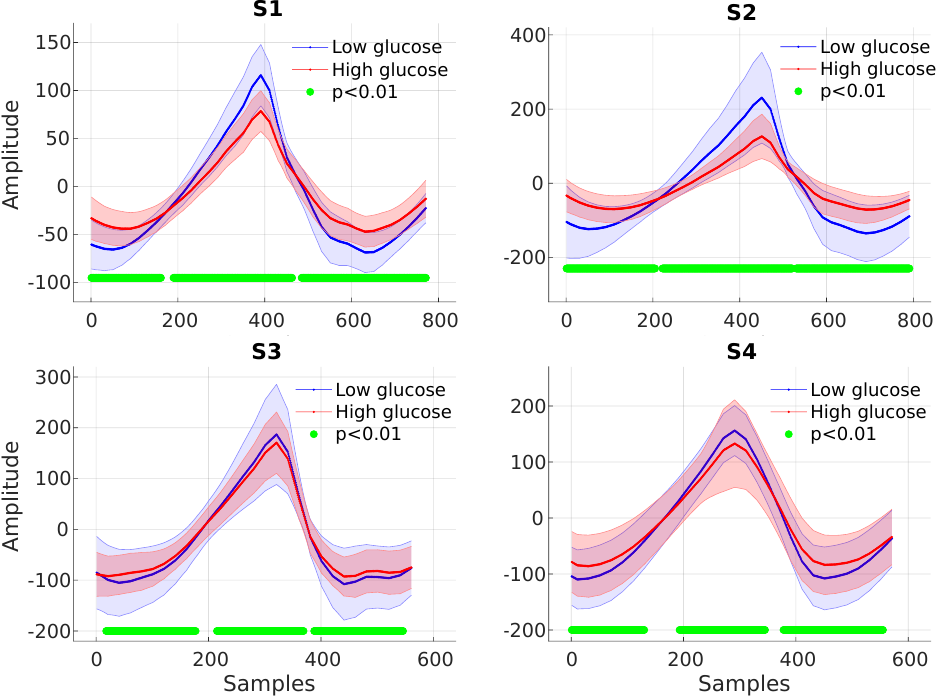
Figure 6. Averaged low − glucose (blue) and high − glucose (red) PPG cycles with the corresponding shaded areas indicating the confidence intervals. The green dots designate time instances where the null hypothesis of no statistical difference between the low − glucose and high − glucose PPG cycles is rejected.